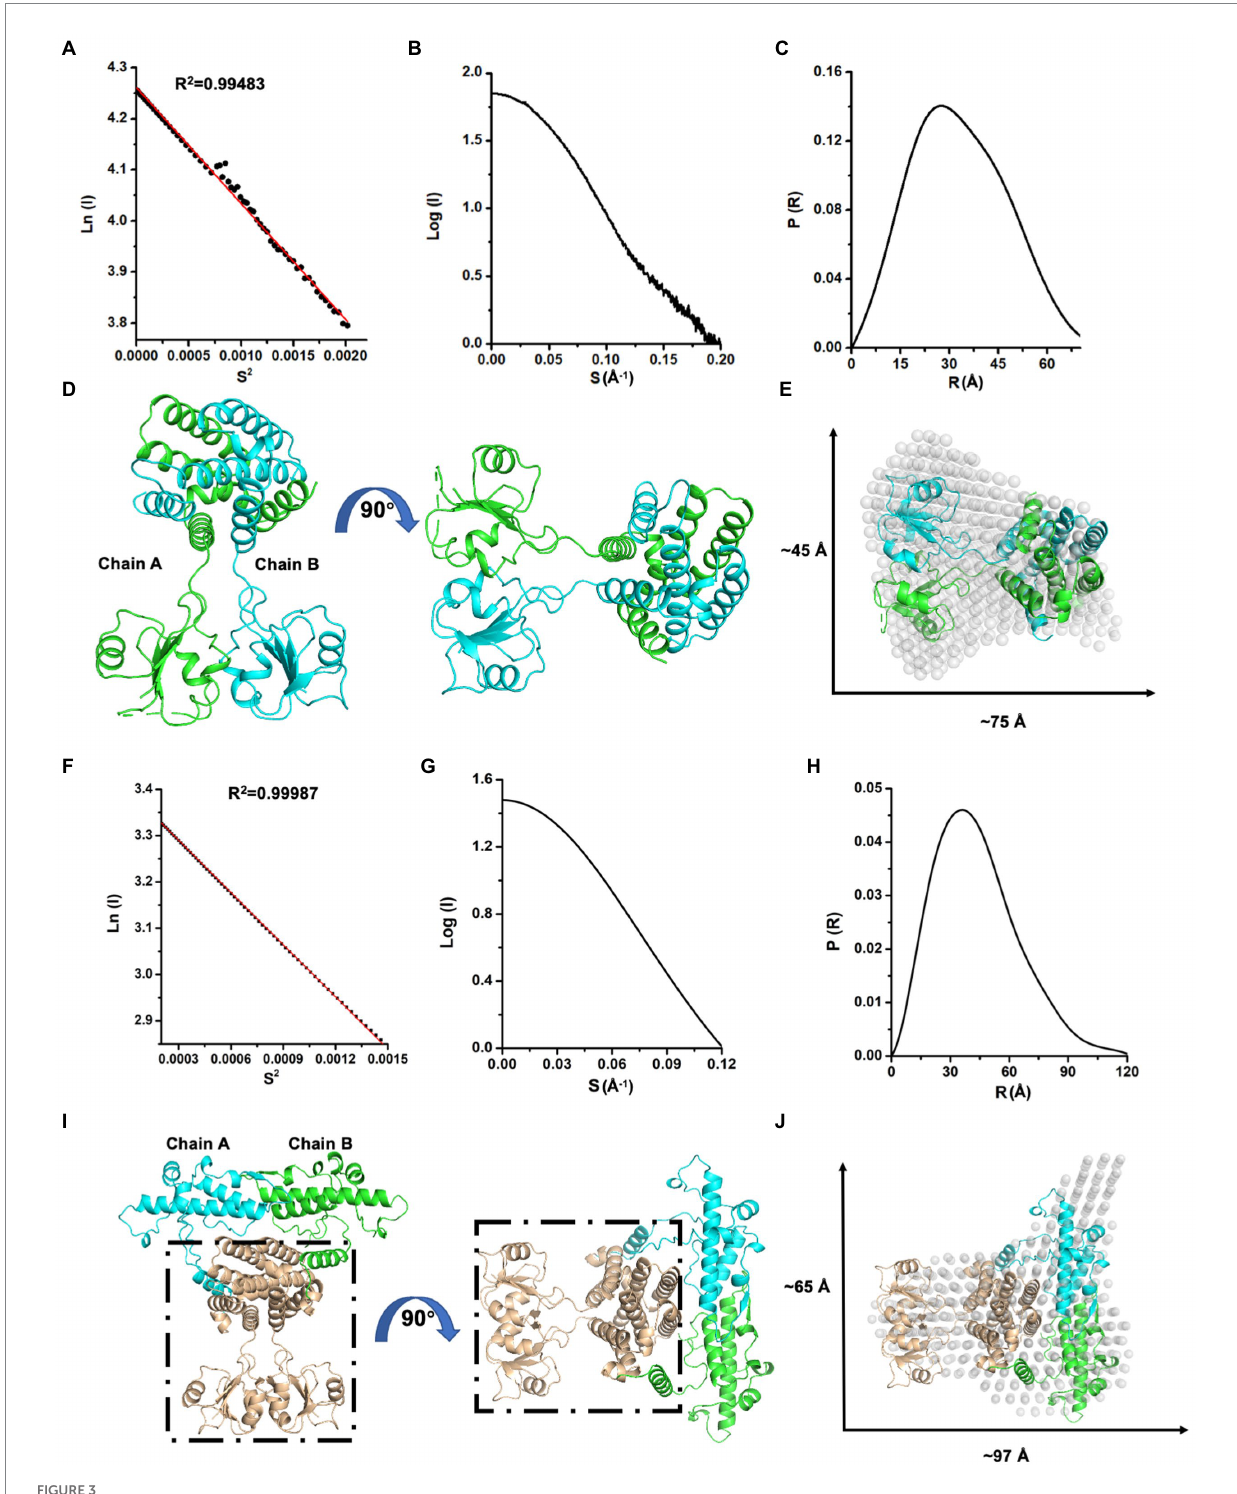
FIGURE 3 SAXS analysis of Mtb-MazG and its truncation MazG (1–185). (A–C) Guinier plot, intensity profile, and the P(R) curve of MazG (1–185). (D) The dimeric structure of MazG (1–185). The two subunits are colored cyan and green, respectively. (E) The de-novo DAMMIN model was overlapped with the crystal structure of MazG (1–185; PDB code: 7YH5, grey). (F–H) Guinier plot, intensity profile, and the P(R) curve of full-length Mtb-MazG. (I) The AlphaFold2 predicted-dimeric structure of full-length MazG. Chains A and B are shown in cyan and green, respectively. The region (1–185) is shown in wheat. (J) The de-novo DAMMIN model was overlapped with the AlphaFold2-predicted structure of full-length MazG